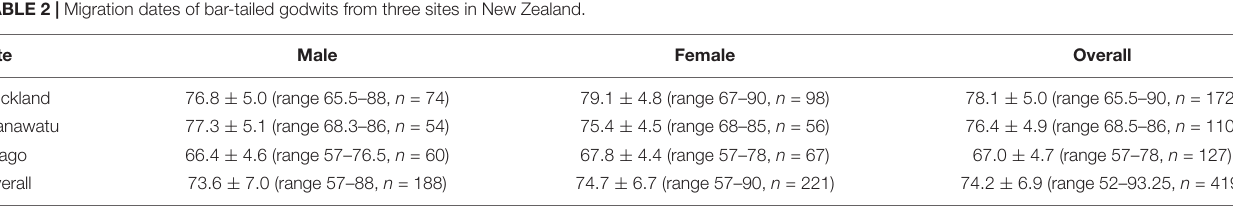
FIGURE 3 | Frequency distributions of migration dates of bar-tailed godwits from three sites in New Zealand. Values represent individual mean departure dates of marked birds (1–4 years per individual) during 2013–2016. TABLE 2 | Migration dates of bar-tailed godwits from three sites in New